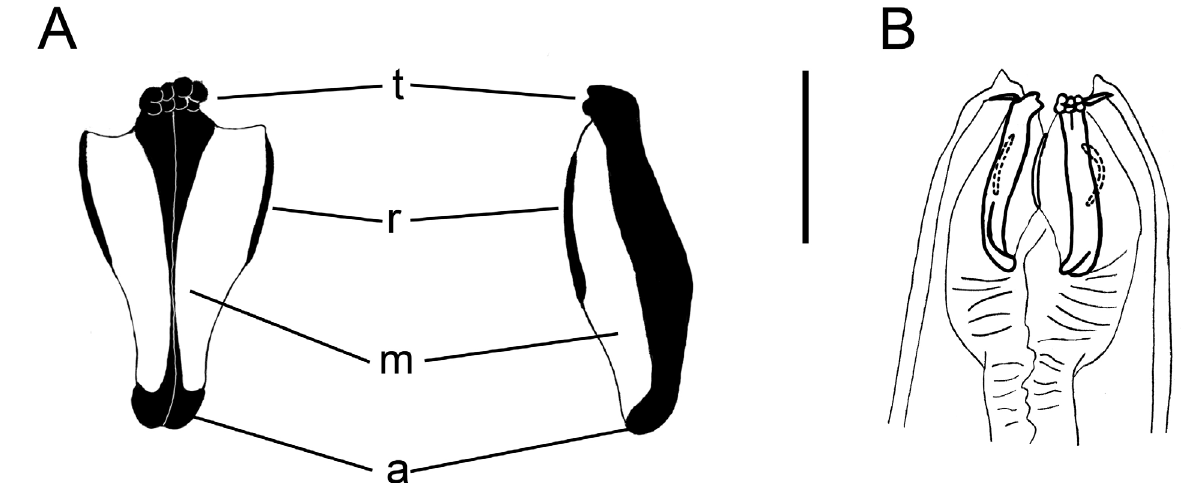
Fig. 5. Pseudocheironchus ingluviosus gen. et sp. nov. A . En face and side views (left and right, respectively) of mandibles. B . Sub-lateral view of female head showing position of mandibles and cuticularised ridges. a = mandible axis; m = membrane; r = cuticularised ridge; t = teeth. Scale bar: A = 10 µ m; B = 20